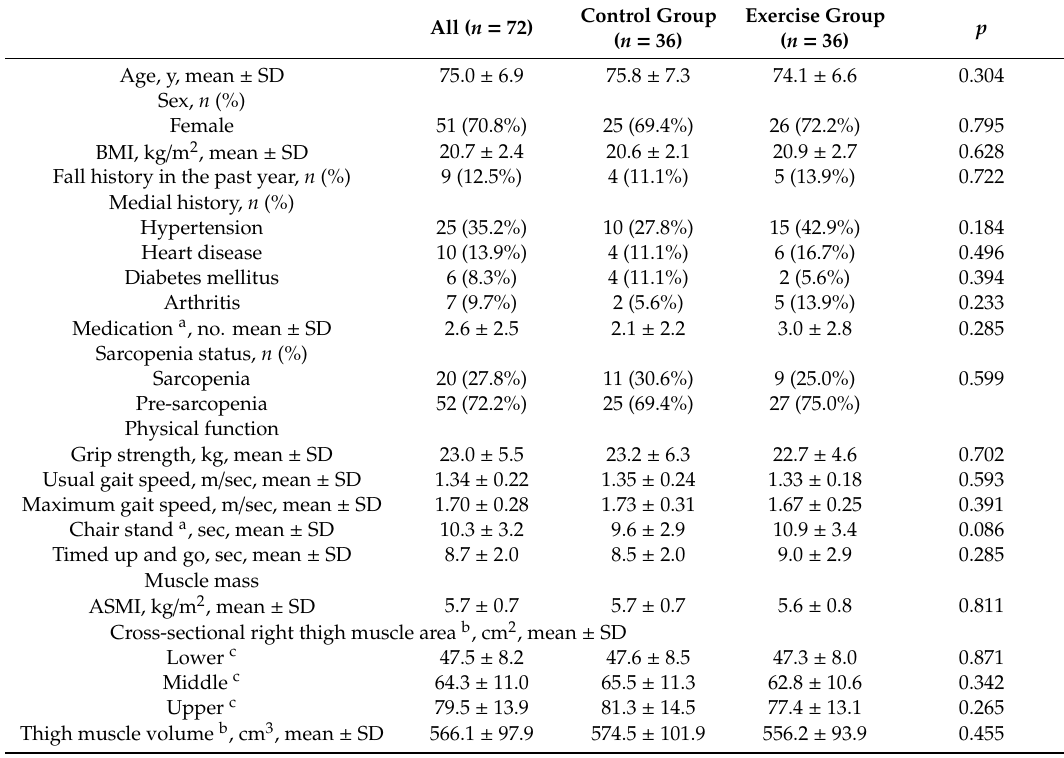
Table 1. Participant characteristics at